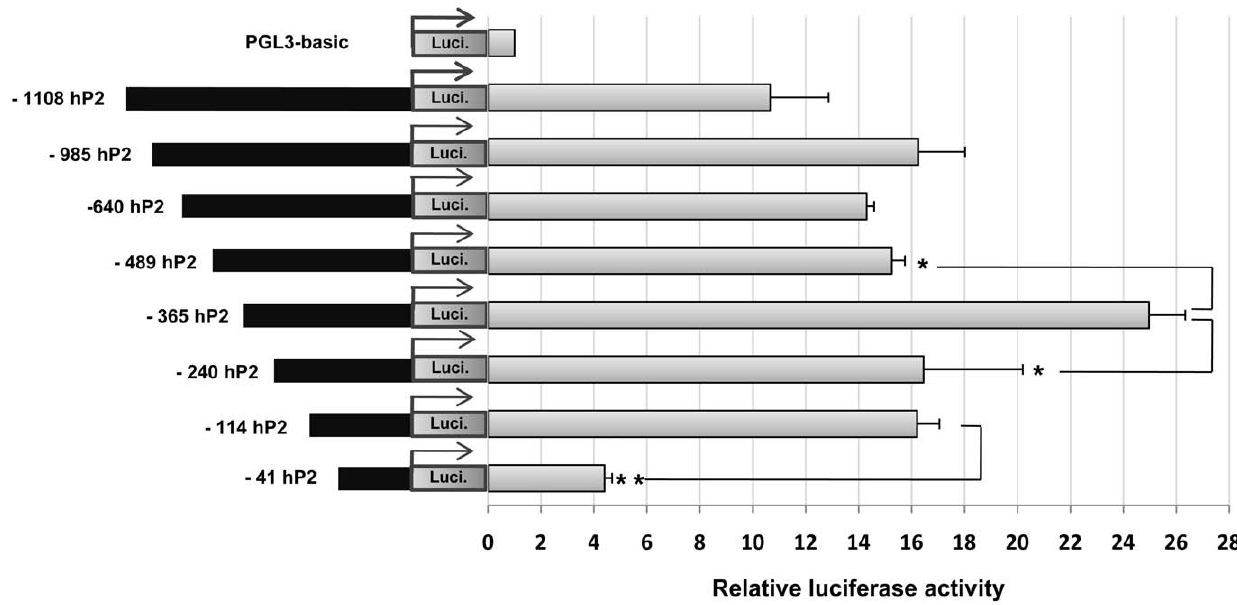
Figure 3. Localization of cis -acting elements of the human PC P2 promoter. Transient transfections of 8 constructs containing of the 5 9 - truncated hP2 promoter into INS-1 832/13 cells were performed to identify the regulatory regions of the hP2 promoter. The basal activity of each 5 9 - truncated hP2 promoter was calculated from the values of luciferase activity which was normalized with the values of b -galactosidase activity to control for transfection efficiency. The normalized luciferase activity of each P2 construct was compared with the activity of the pGL3-basic vector which was arbitrarily set to 1 and presented as the relative luciferase activity. *P value , 0.05, **P value , 0.01.